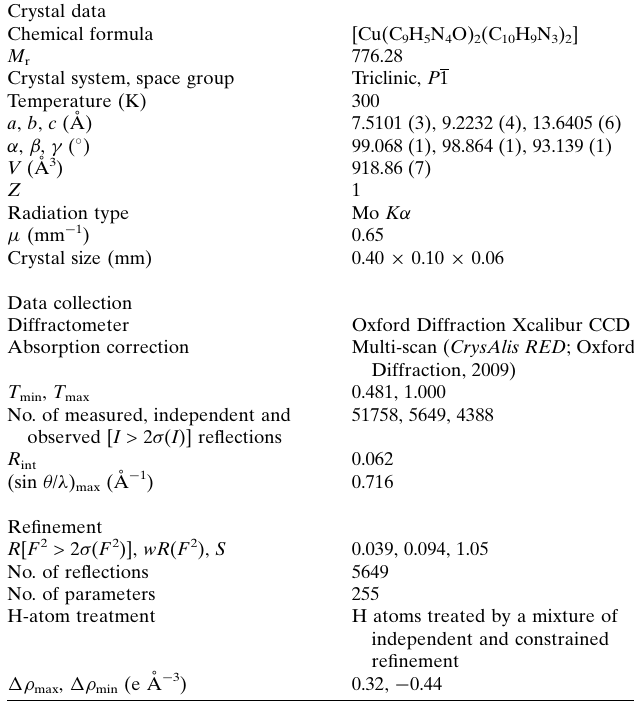
Table 3 Experimental details. Crystal data Chemical formula